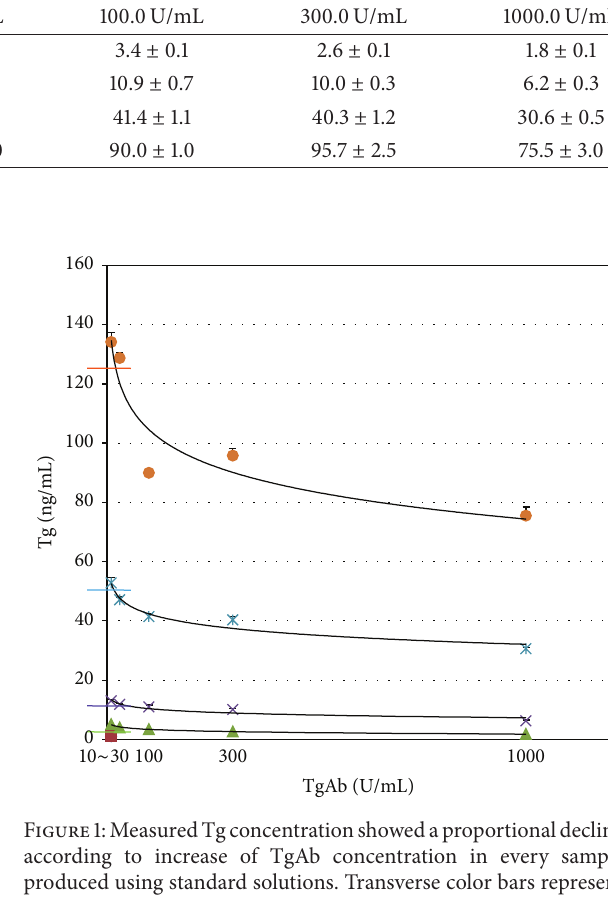
Table 3: Decline of measured Tg value by TgAb in samples produced using Tg and TgAb standard solutions. Expected Tg concentration